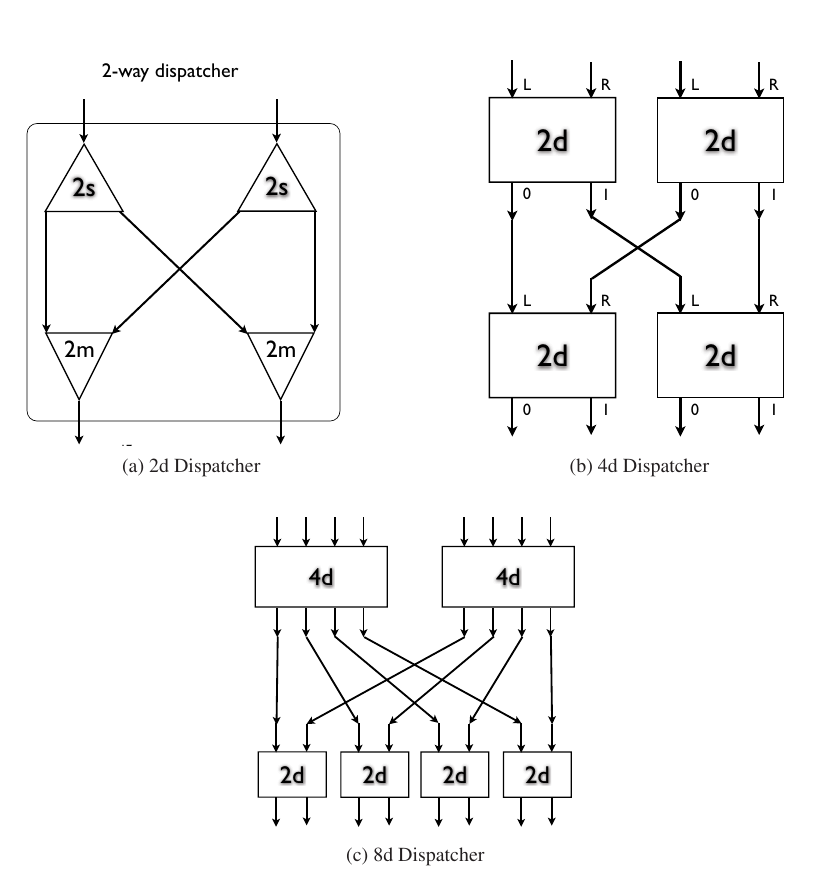
Figure 3: Schemes of dispatchers with 2, 4, and 8 inputs /